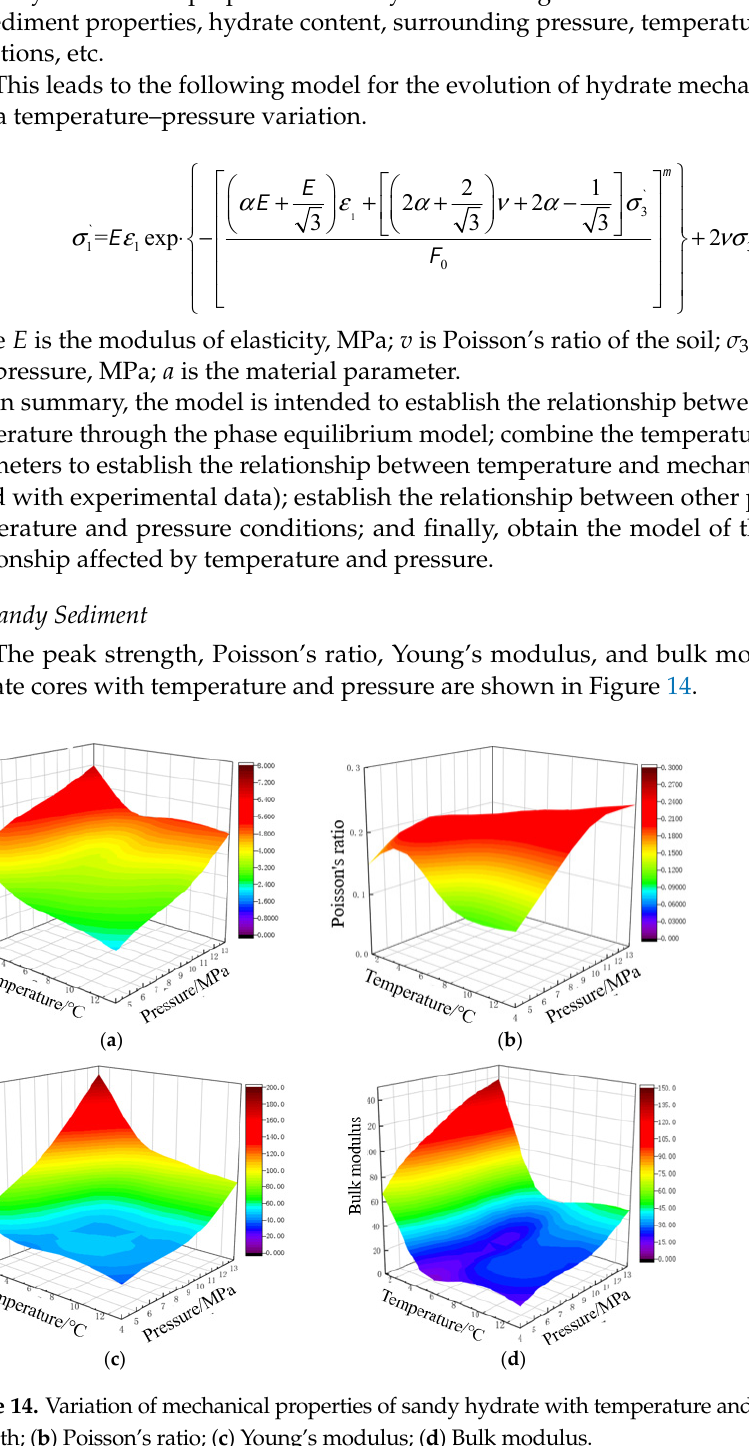
( d ) Figure 15. Variation of mechanical properties of muddy silt hydrate with temperature and pressure ( a ) Peak Strength; ( b ) Poisson’s ratio; ( c ) Young’s modulus; ( d ) Bulk modulus. When the saturation/mass abundance is constant, the peak core strength tends to de- crease with increasing temperature and lowering pressure, as demonstrated by the com- parisons above. Under experimental settings, the peak strength of sandy hydrate varies between 6.9 and 13.1 MPa, whereas the peak strength of muddy silt hydrate varies be- tween 0.77 and 1.5 MPa. Temperature and pressure have a bigger impact on the elastic modulus than Poisson’s ratio. Under experimental conditions, Poisson’s ratio of sandy hydrate ranged between 0.12 and 0.18, and Poisson’s ratio of muddy silt hydrate ranged